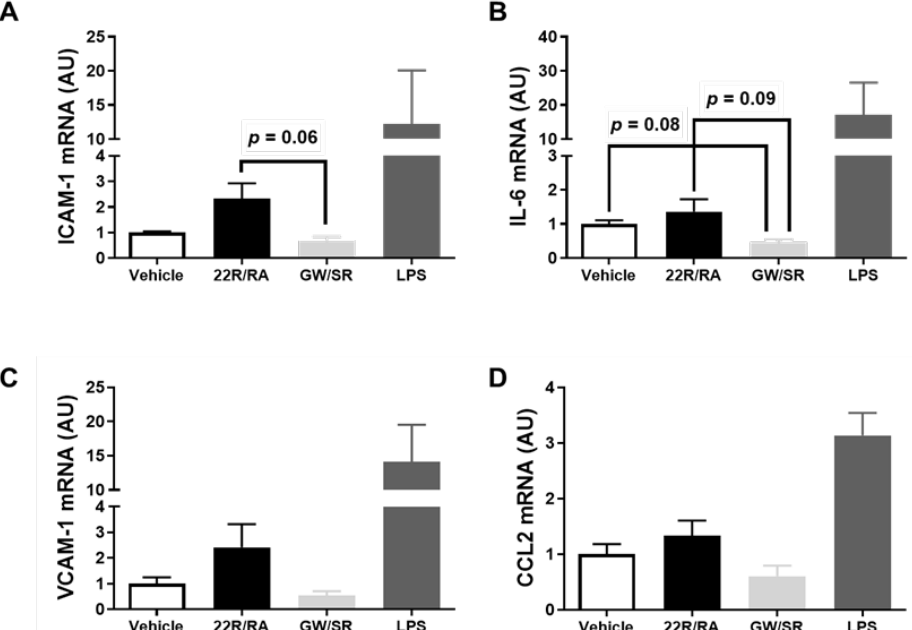
Figure 4. Effect of combining LXR and RXR agonist treatments on pro-inflammatory gene expression in immortalized mouse aortic endothelial cells (iMAEC). ( A – D ) iMAEC were cultured in basal conditions and either vehicle treated, treated with 22(R)-hydroxycholesterol and 9-cis-retinoic acid (22R/RA), or treated with GW3965 and SR11237 (GW/SR), and RT-qPCR was used to measure ICAM-1 ( A ), IL-6 ( B ), VCAM-1 ( C ), and CCL2 ( D ) mRNA expression in the treated iMAEC. LPS-treated iMAEC acted as a positive control. Three independent experiments with two biological replicates per treatment for each experiment. AU, arbitrary units; data are mean ± SEM.